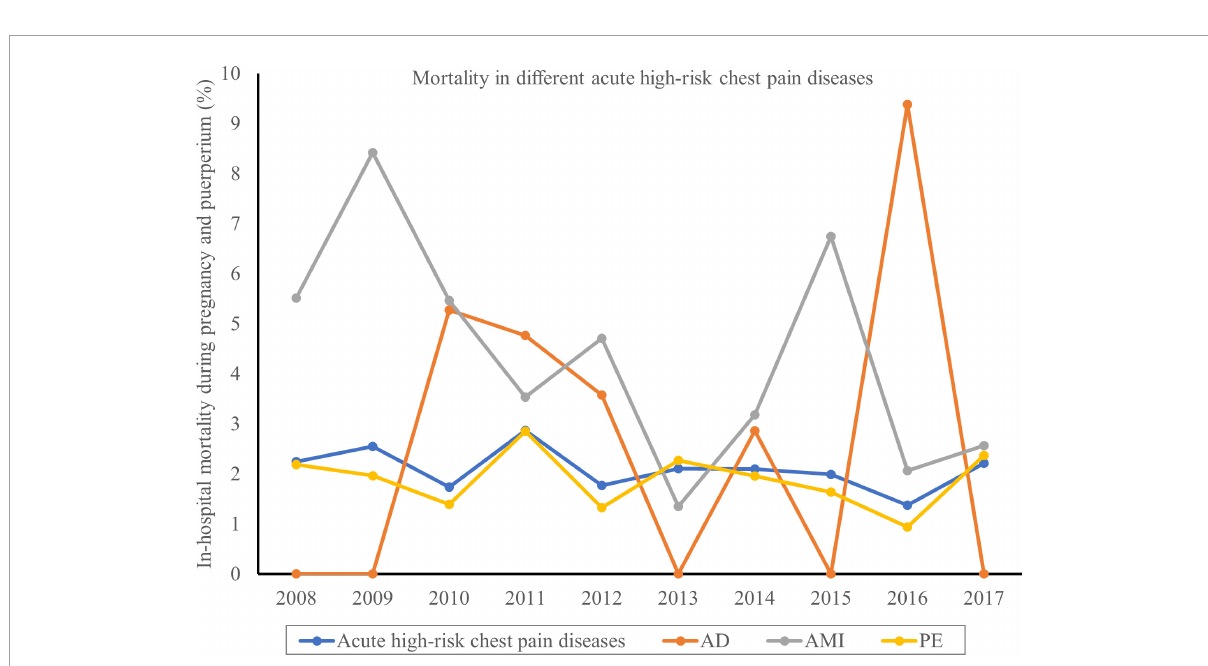
FIGURE4 Temporal trends of the mortality in acute high-risk chest pain diseases during pregnancy and puerperium. The in-hospital mortality of acute high-risk chest pain diseases mildly decreased but still remained high (2.24% in 2008 vs. 2.21% in 2017; P trend =